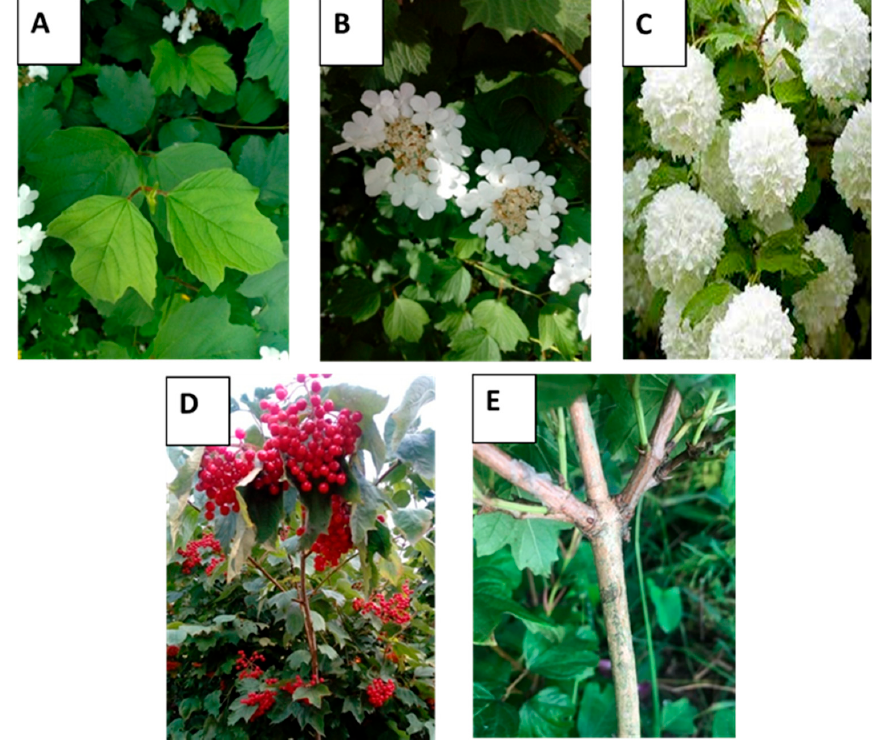
Figure 1. Leaves ( A ), flowers of edule variety ( B ), and flowers of decorative variety ( C ), fruits ( D ), and bark ( E ) of V. opulus growing in central Poland.